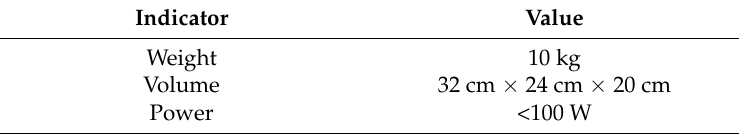
Table 9. The structuring indicators of the prototype single machine system.